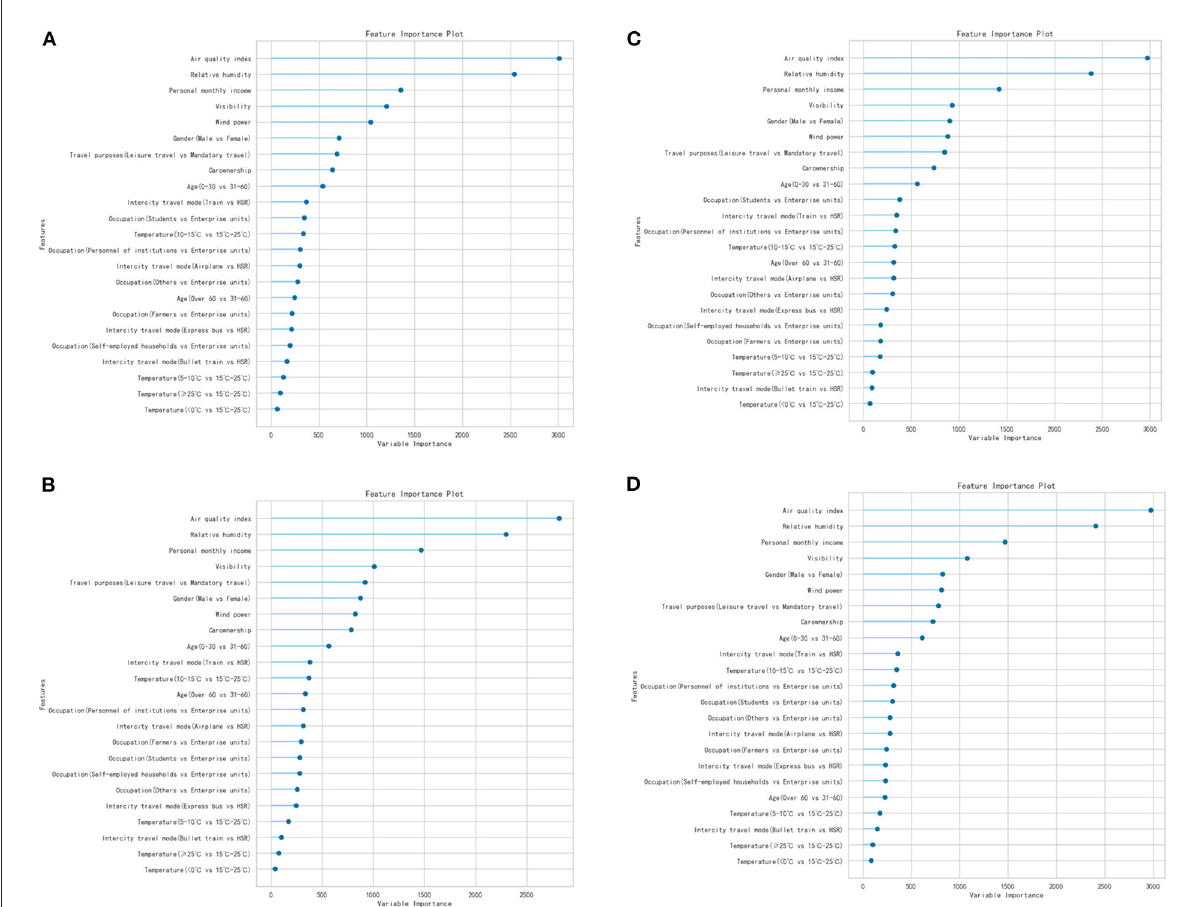
FIGURE1 Importance analysis of support vector machine (SVM). (A) Happiness degree. (B) Panic degree, (C) Anxiety degree, (D) Tiredness